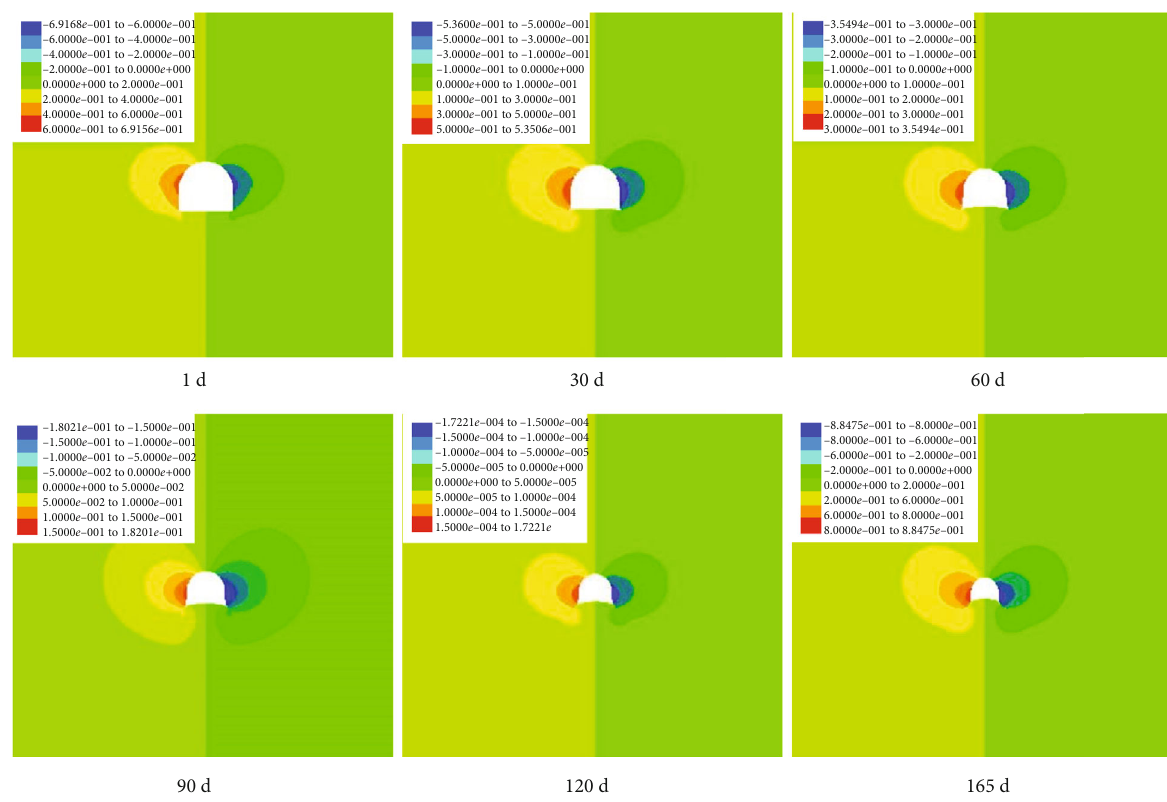
Figure 12: Horizontal displacement contours.